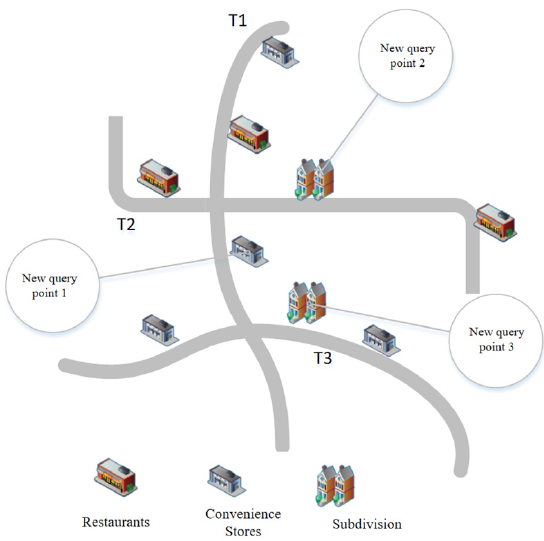
Figure 10. Continuous query attack model.